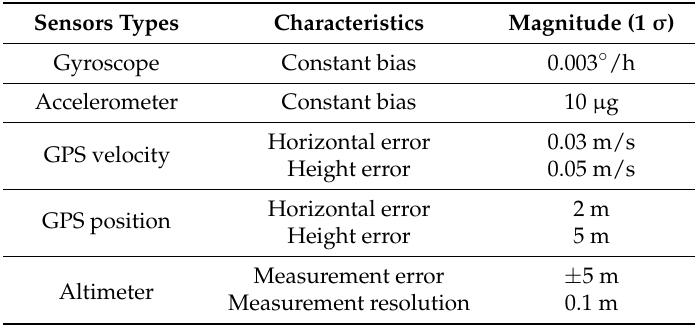
Figure 9. Field test trajectories on Google map.